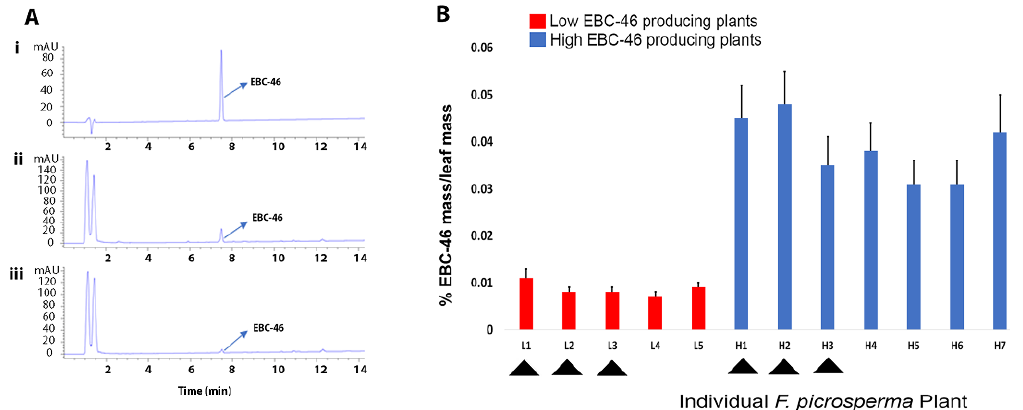
Figure 1. EBC-46 concentration in leaves of 12 different Fontainea picrosperma plants. ( A ) HPLC chromatograms at 249nm mAU of ( i ) EBC-46 analytical standard at 0.1 mg/mL (retention time at 7.496 min), ( ii ) leaf extract from an example high-EBC-46-producing F. picrosperma plant, and ( iii ) leaf extract from an example low-EBC46-producing F. picrosperma plant. ( B ) Average EBC-46